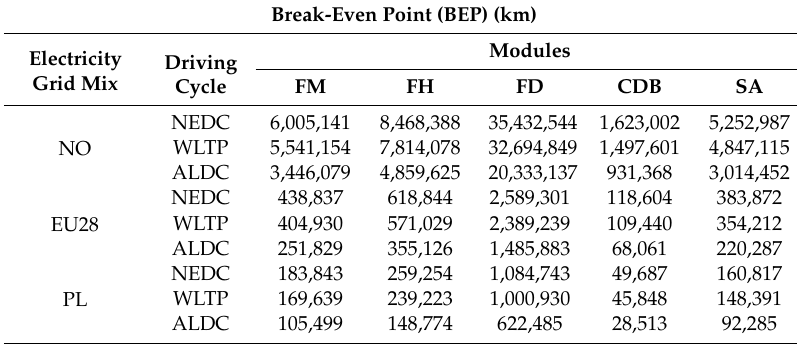
Table A5. BEP for the considered sustainability case